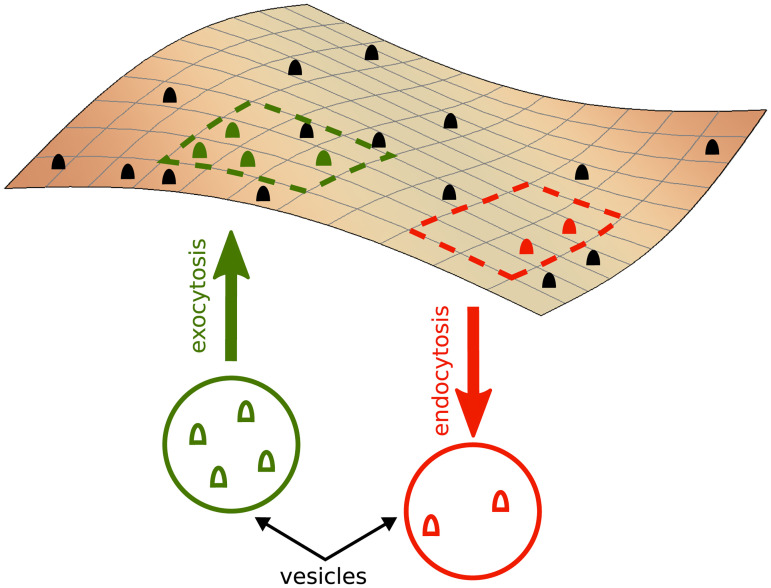
Schematic illustration of the receptor cycling model.Black, green, and red full symbols represent, respectively, the receptors which survive or will be added or eliminated in the next time step. Dashed lines indicate the affected zones by endo/exocytosis events.